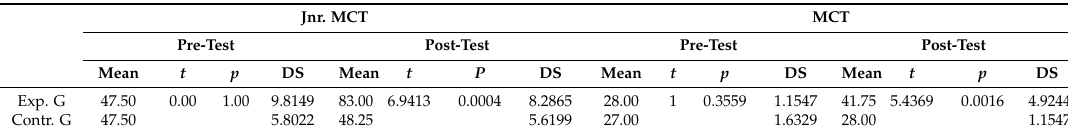
Table 6. Student’s t tests for independent groups (experimental versus control) applied to Jnr MCT and